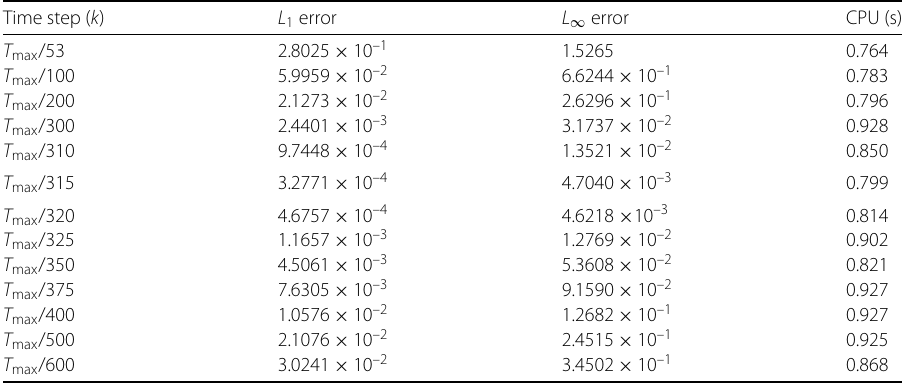
Table 4 L 1 and L ∞ errors and CPU time at some different values of time-step size k for Problem 1 and spatial mesh size h = 0.01, (cid:5) = 0.01 using FTCS- (cid:5) , where T max = 2.5 × 10 –3